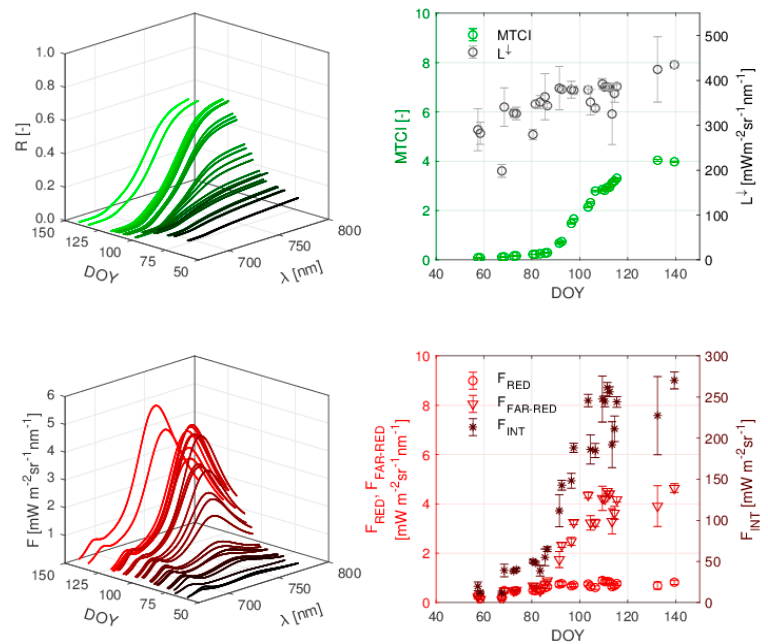
Figure 12. Temporal evolution of fluorescence and reflectance along growing season of forage crop between February to May: ( top-left ) reflectance spectrum; ( bottom-left ) fluorescence spectrum; ( top-right ) MTCI and downwelling radiance; ( bottom-right ) F RED , F FAR-RED and F INT values.